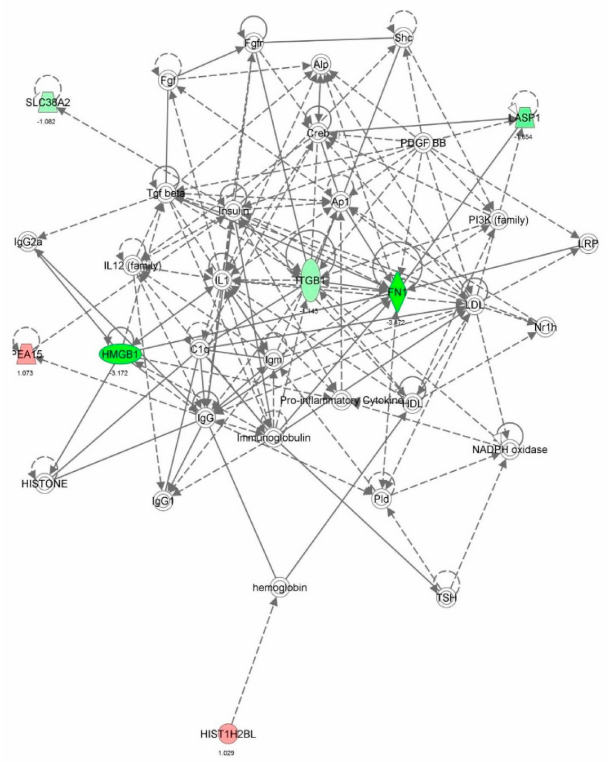
Figure 25. Vancomycin regulated cell-to-cell signaling and interaction, tissue development, and cardiovascular system development and function. Red indicates an up-regulation; green indicates a down-regulation. The intensity of green and red colors indicates the degree of down- or up-regulation. Solid arrow indicates direct interaction and dashed arrow indicates indirect